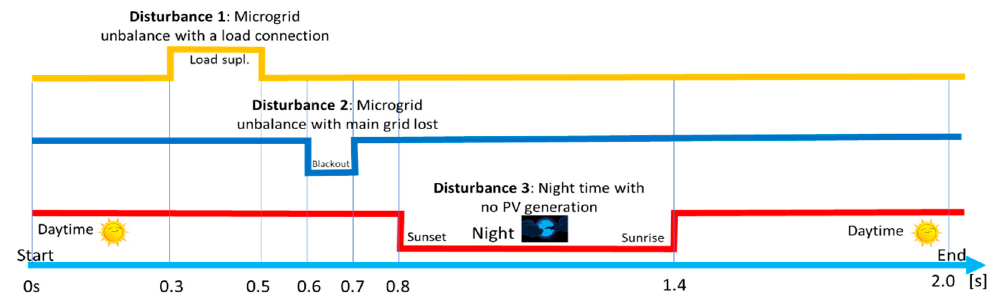
Figure 4. Scenario 1 timeline: applying the three disturbances as separate events (non-overlapped).